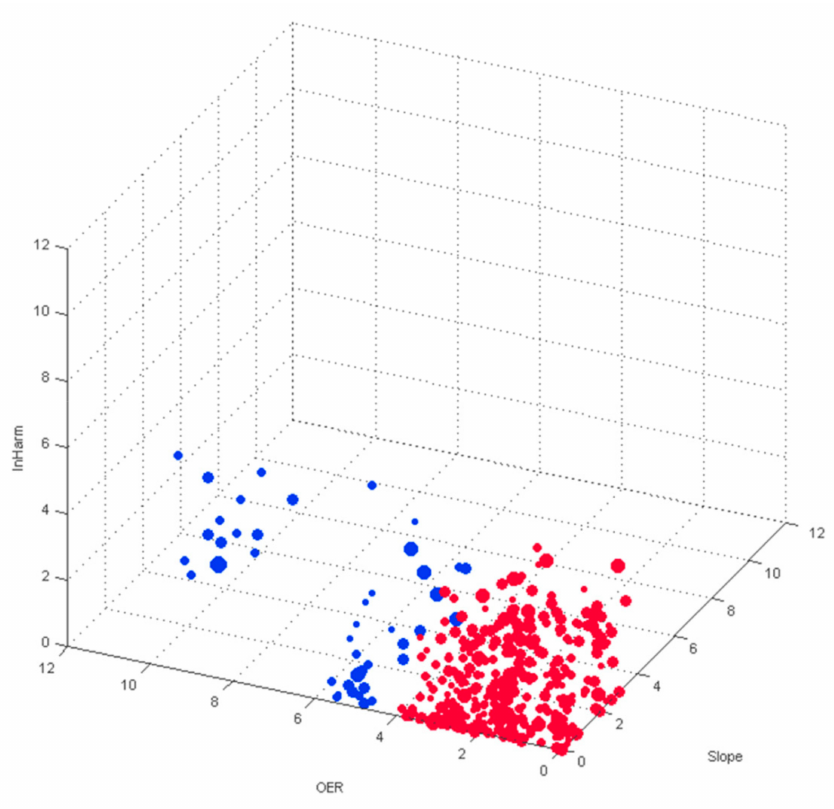
Figure 6. Scatterplot, with the “Distortion” settings being displayed as the dot size. Colors indicate the two di ff erent clusters as calculated by the k-means analysis. All displayed values are z -scores as distance in standard deviations (per participant) from